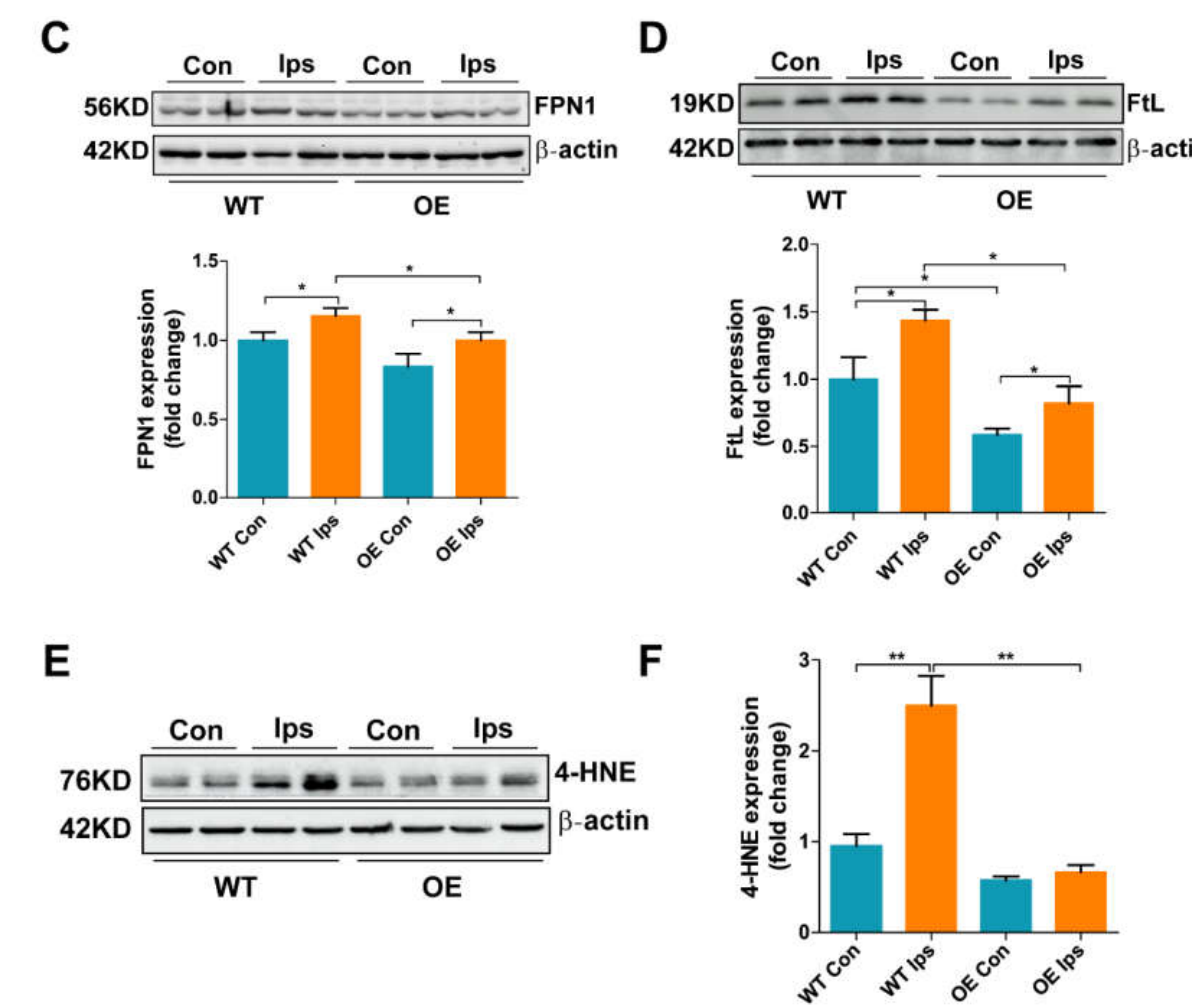
Figure 4. Overexpression of FtMt rescues I/R-induced iron dysregulation and oxidative stress in BMVECs. Western blot and densitometric analyses of ( A ) TfR1, ( B ) DMT1(+IRE), ( C ) FPN1, ( D ) FtL and ( E , F ) 4-HNE. The results are normalized to the β -actin levels and the data are expressed relative to the mean value in the WT Con group ( n = 4). The results are presented as the mean ± SEM. * p < 0.05, ** p < 0.01.